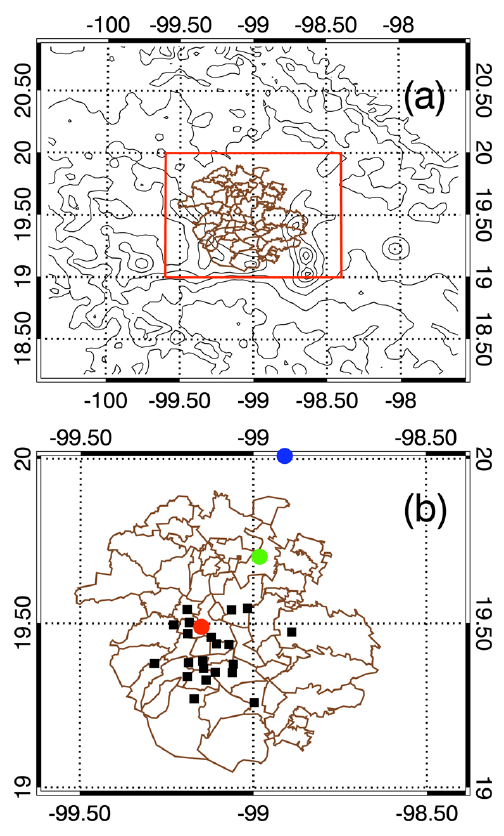
Figure 1 Fig. 1. WRF-CHEM simulation domain. Black squares represent the RAMA (Mexico City Ambient Air Monitoring Network) sites. The red, blue, and green circles represent the T0, T1, and T2 super- sites,